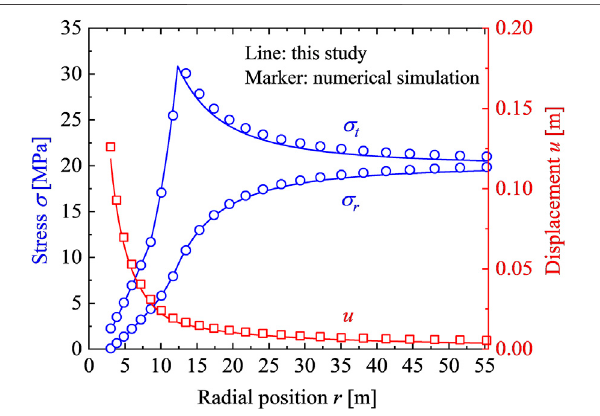
The two-dimensional rotational axisymmetric numerical model is shown in Figure 4 . The in-plane axial in situ stress q is taken as 2 μσ 0 to satisfy the stress boundary conditions in the plane strain problem, which is exerted on top of the model. The right boundary is restrained by the con fi ning stress σ 0 , while the bottom end set as a roller, and left boundary is taken as a symmetrical boundary. The strain-softening constitutive model